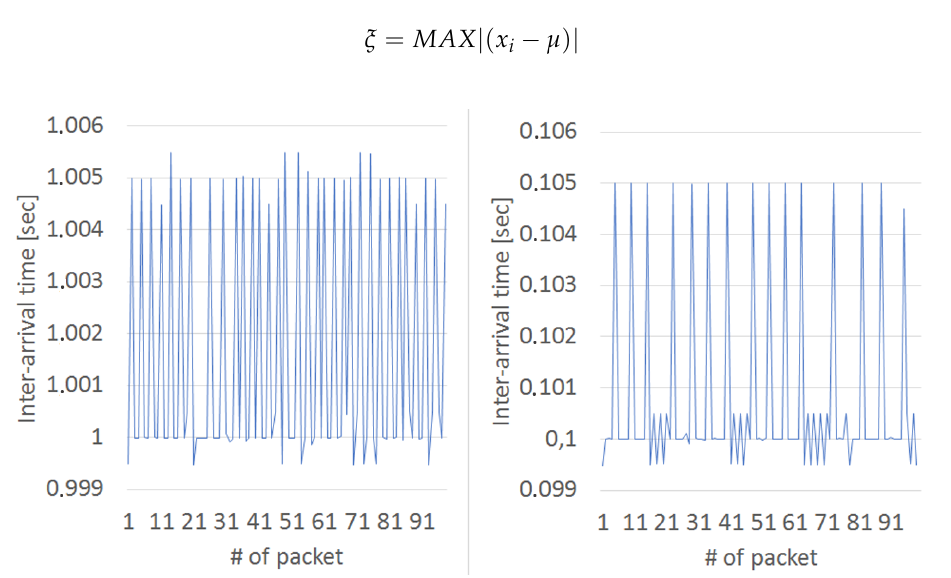
Figure 20. Jitter results ( left ): 100 Byte packets, 1000 ms sending period, ( right ): 100 Byte packets, 100 ms sending